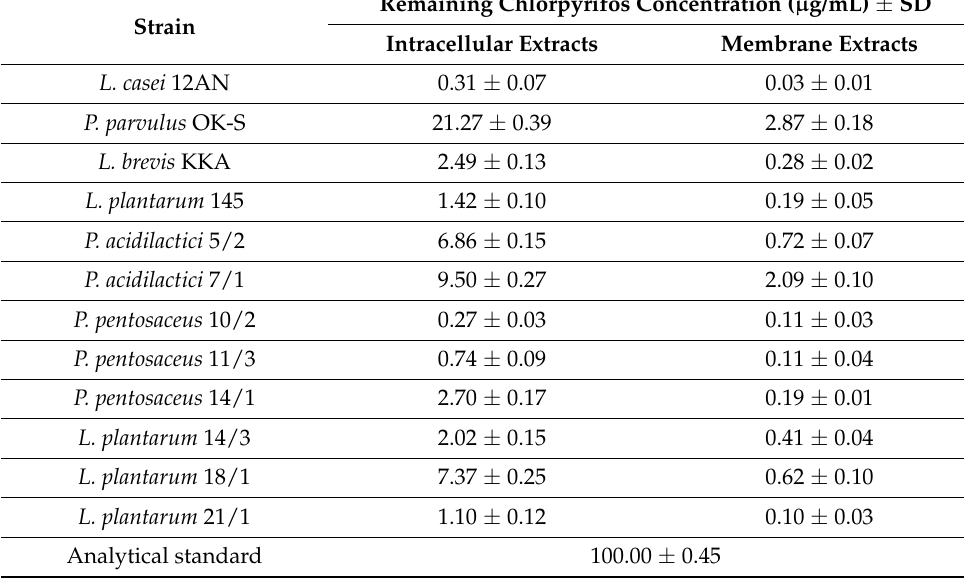
Table 2. Amount of chlorpyrifos bound to intracellular extracts and membrane extracts after 24 h incubation with selected strains of lactic acid bacteria (LAB). The experiments were conducted for whole live LAB cells. The initial concentration of an individual pesticide was 100 µ g/mL. The presented results are mean from two measurements ± SD.